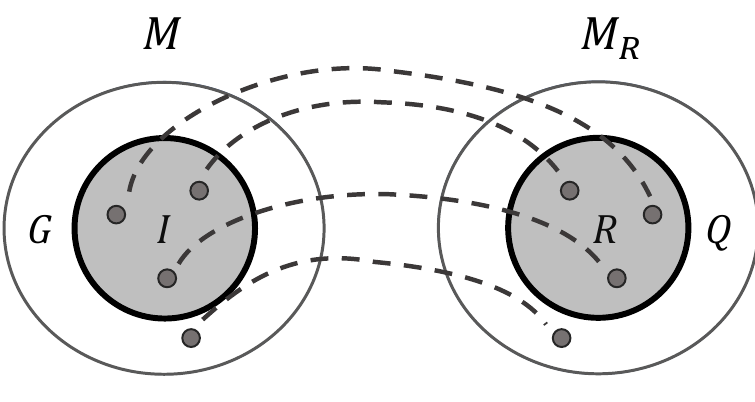
Figure 1 . Schematic figure of M and M R . A region in M can be an island ( I ) for some reference region R ⊂ M R only if it satisfies the four necessary conditions. G is the complement of I , and Q is the complement of R . Condition 1 requires a large degree of entanglement, represented by the dashed